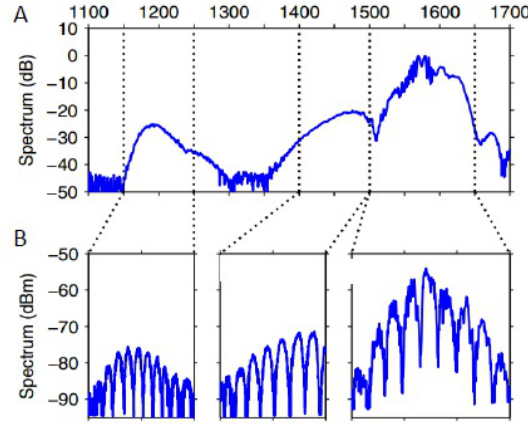
Fig. 9. Coherent supercontinuum generation in a silicon waveguide using fs pulses . a) The spectrum a) and b) the fringes obtained with the interferometric setup of Figure 10 show that the supercontin- uum is coherent. Adapted from reference [26].